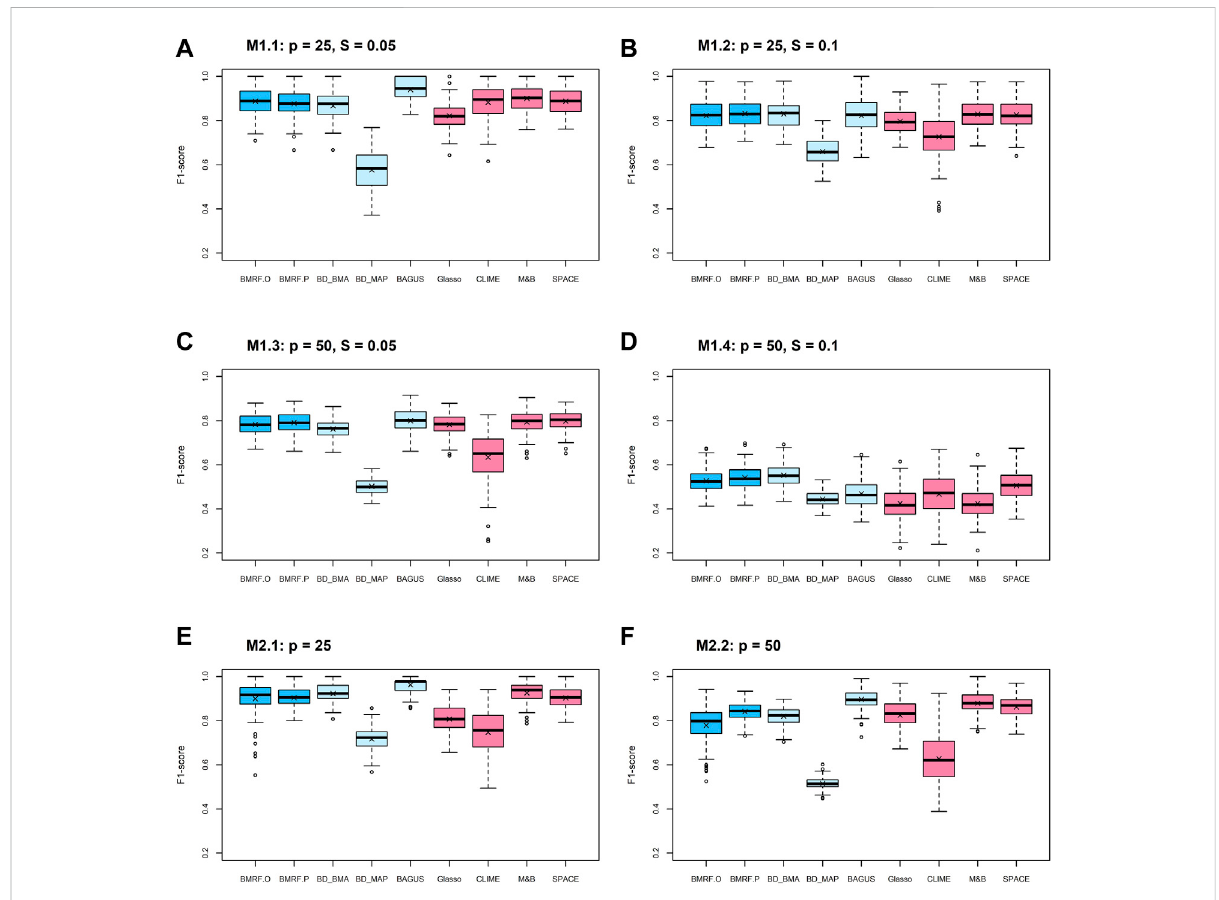
FIGURE 1 Boxplots of F1-scores from 100 replications under each method. Each sub fi gure corresponds to a setting with a combination of p and S . Note that the blue boxplots correspond to the fi ve Bayesian algorithms and the pink ones correspond to the four penalized